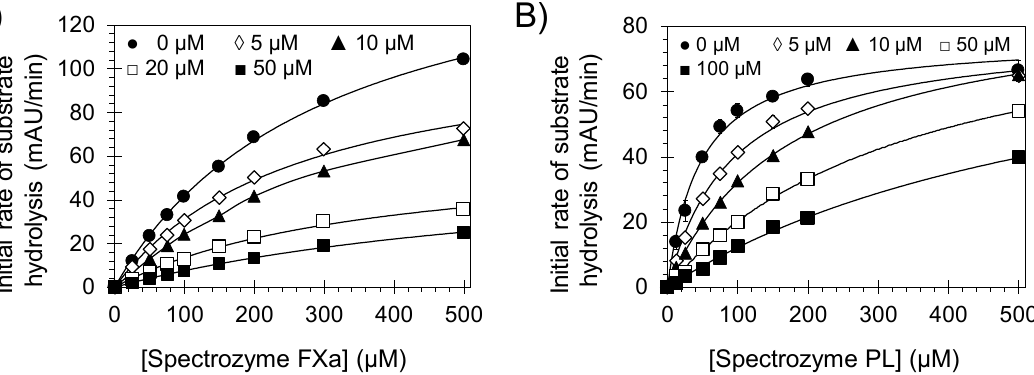
Figure 6. Michaelis-Menten kinetics of human FXa ( A ) and human plasmin ( B ) in the presence of Figure 6. Michaelis ‐ Menten kinetics of human FXa (A) and human plasmin (B) in the presence of di ff erent concentrations of pentamidine isethionate (0–100 µ M). The initial rate of hydrolysis at various different concentrations of pentamidine isethionate (0–100 μ M). The initial rate of hydrolysis at substrate concentrations was measured spectrophotometrically in pH 7.4 bu ff er at 37 ◦ C. Solid lines various substrate concentrations was measured spectrophotometrically in pH 7.4 buffer at 37 °C. Solid represent the nonlinear regressional fits for the data using Equation (2) to yield K M and V MAX lines represent the nonlinear regressional fits for the data using Equation 2 to yield K M and V MAX . Table 3. Hydrolysis of the chromogenic substrate Spectrozyme FXa by human FXa and Spectrozyme PL by human plasmin in the presence of pentamidine isethionate . a)